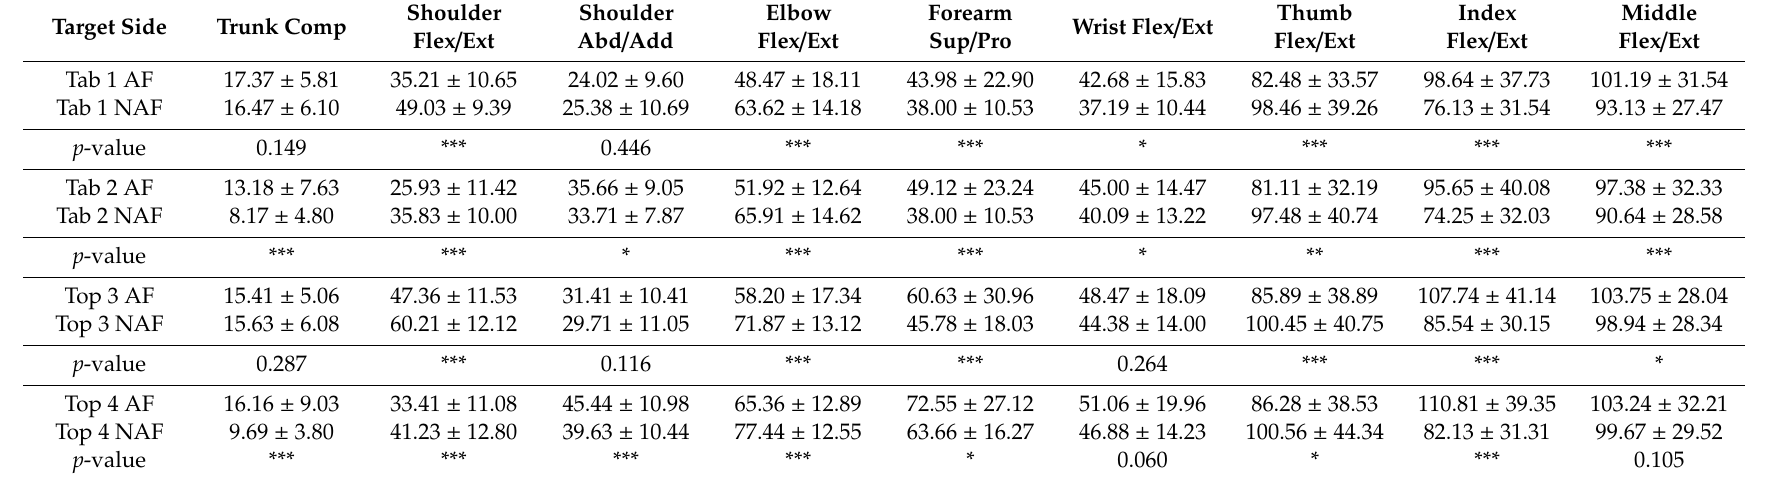
Table A1. Di ff erences in range of motion (AF vs. NAF) for the main upper limb degrees of freedom per target